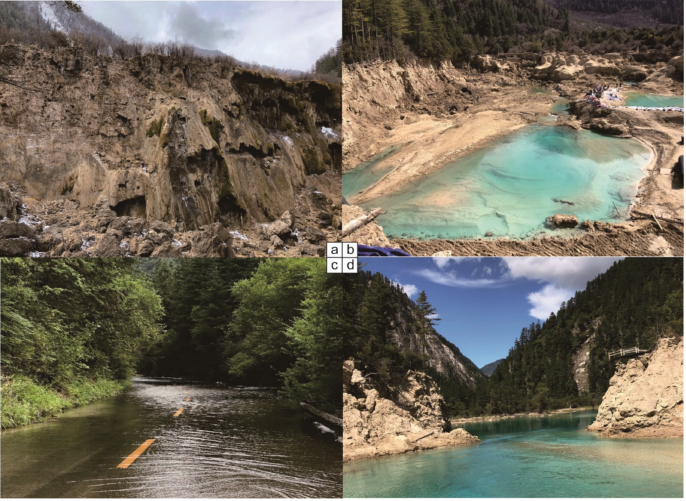
Figure 1. Several waterscapes a ff ected by the Jiuzhaigou earthquake: ( a – d ) represent the Nuorilang Waterfall cuto ff , the dried-up Sparking Lake, a section of road in the west valley filled with water, and the Sparking Lake dam break,